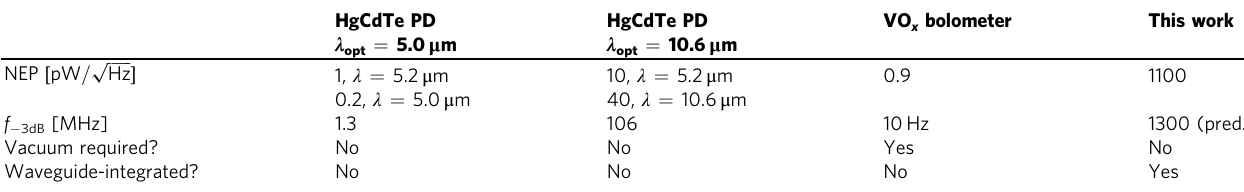
Table 2 Comparison of our detector with inferred room-temperature performance metrics for two HgCdTe photodiodes optimized for two different wavelengths (from ref. 31 ) and a VO x bolometer (from ref. 32 ) available off the shelf. For the photodiodes, the NEP is extrapolated from the speci fi ed detectivity for a detector scaled down to match the size of a diffraction- limited spot with NA = 0.3, which is the acceptance NA of these detectors. For the bolometer, we give the NEP of a single 17 × 17 μ m bolometer pixel as calculated from the speci fi ed noise-equivalent temperature difference as described in Rogalski 7